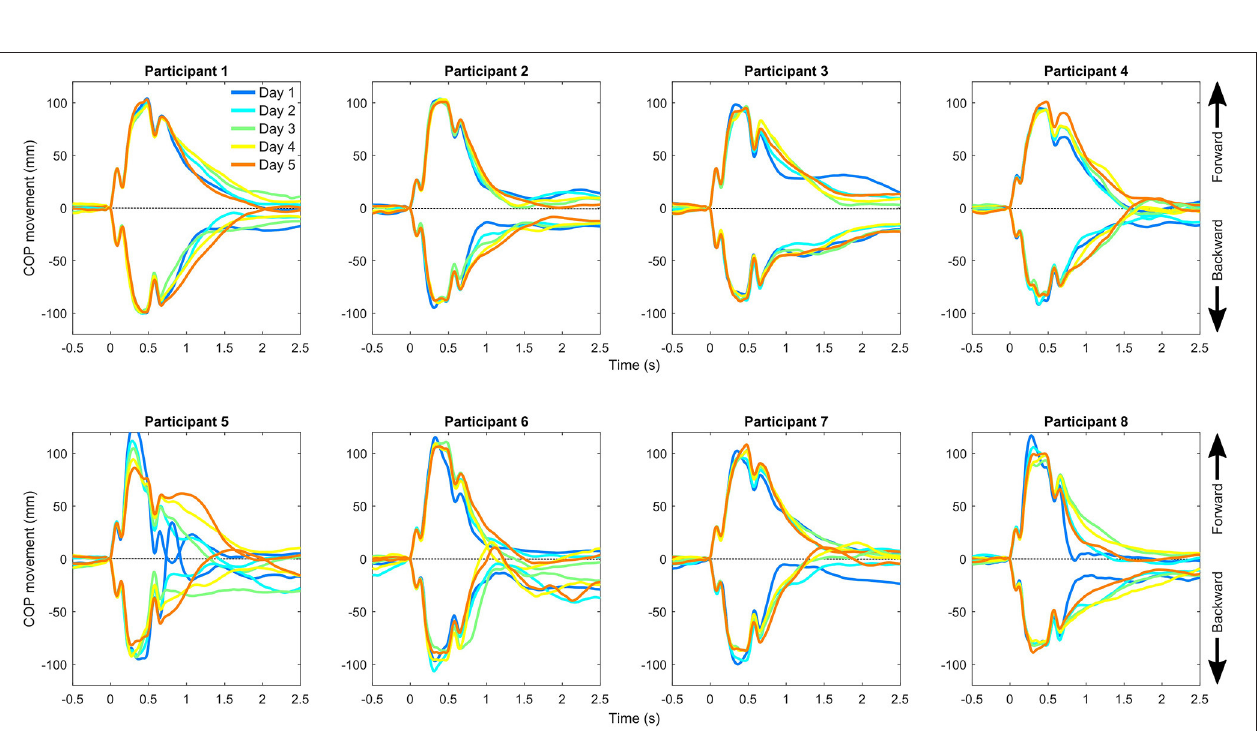
FIGURE 4 | Center of pressure (COP) movement relative to the belt in the fast backward and forward perturbation protocols separately for each participant and measurement day. The positive direction of the center of pressure movement is forward (direction of gaze) and occurs in response to backward perturbation of the belt.